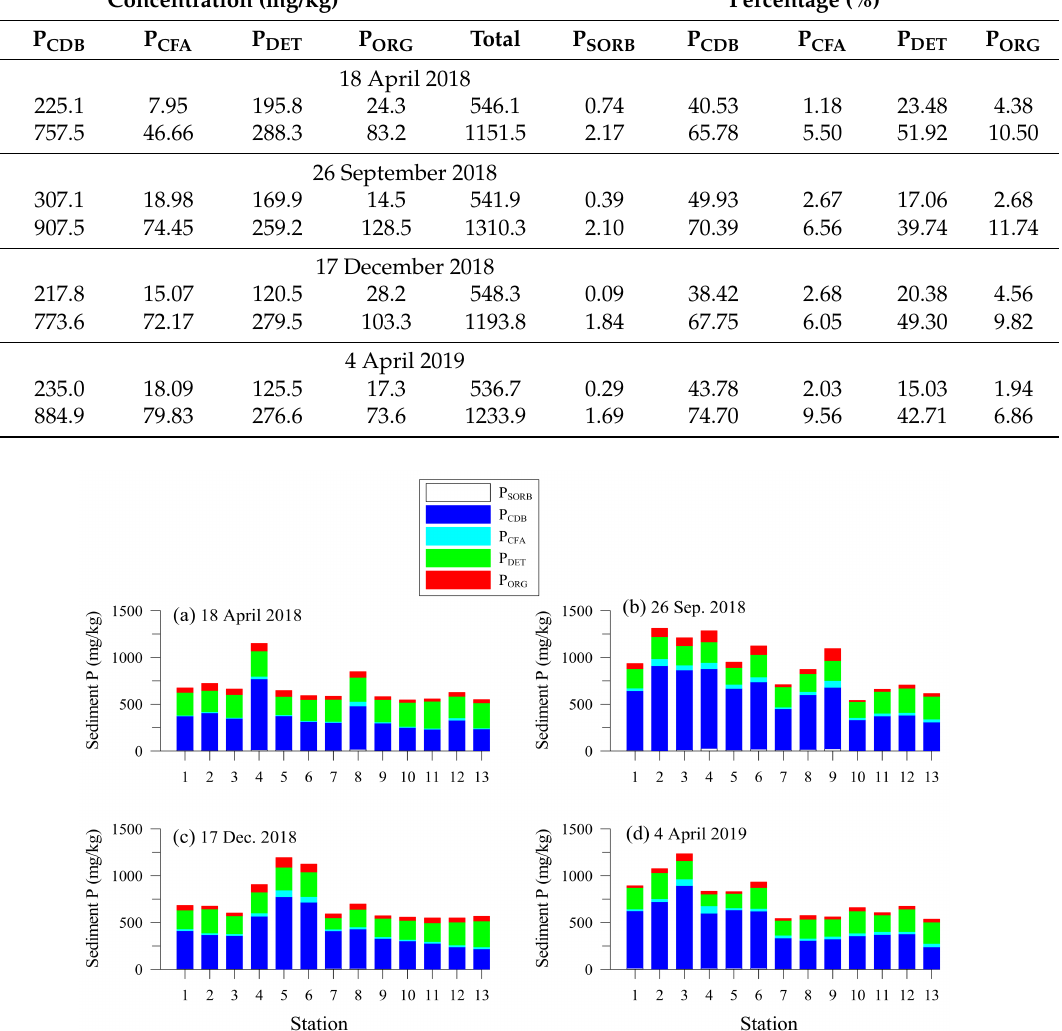
Figure 6. Seasonal distributions of the five P concentration fractions in the DRE surface sediments during the different surveys ( a ) 18 April 2018, ( b ) 26 September 2018, ( c ) 17 December 2018, and ( d ) 4 April